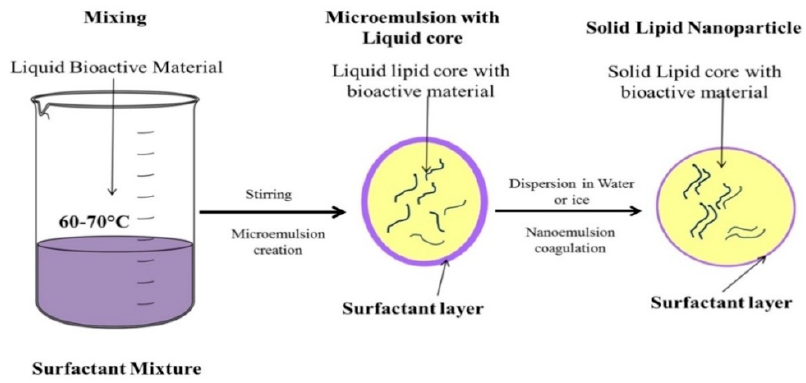
Figure 3. Schematic representation of SLN production by microemulsion technique.